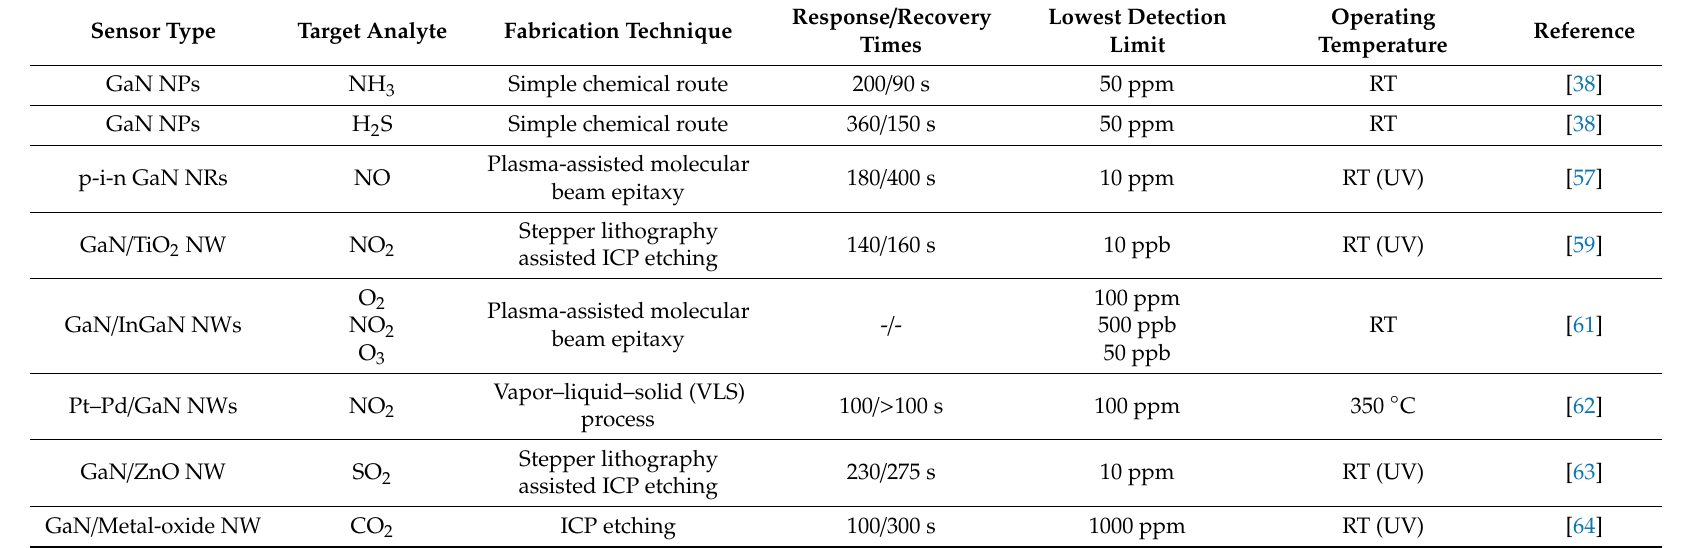
Table 4. Synthesis method and sensing properties of GaN nanostructures-based various oxidizing and reducing gas